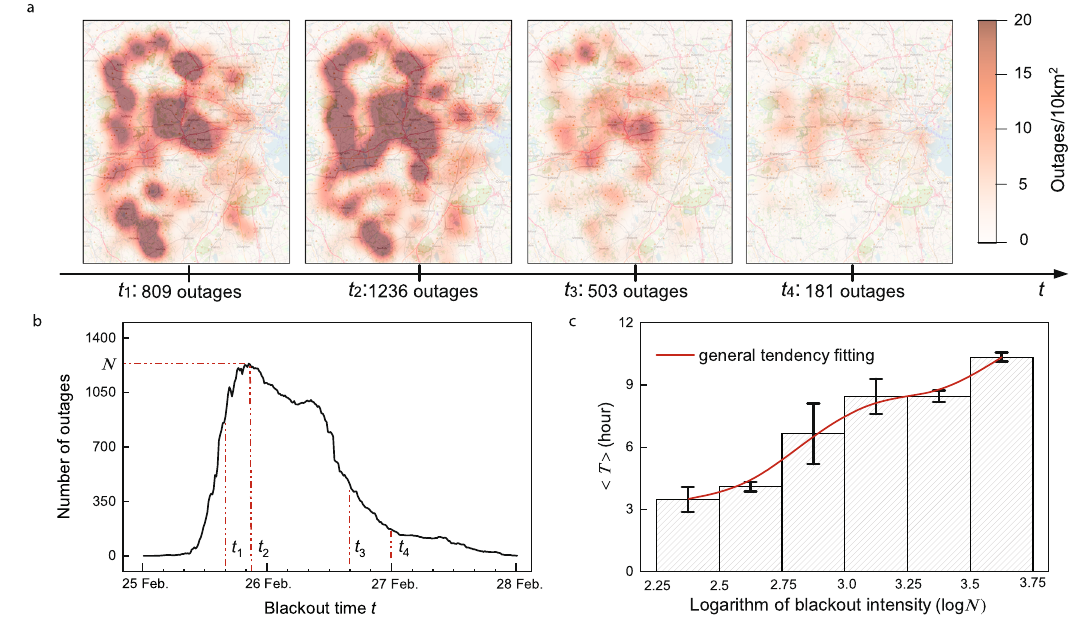
Fig. 2 | The impact of blackout intensity on recovery. a Illustration of the spa- tiotemporal evolution of a blackout on 25 February 2019 in Massachusetts. Red regions represent outages. Heatmap reproduced using OpenStreetMap and QGIS software. b Numberofoutagesduringtheevolutionoftheblackoutin a .Attime t 2 , theoutagenumberreachesitspeakvalue,whichisde fi nedastheblackoutintensity